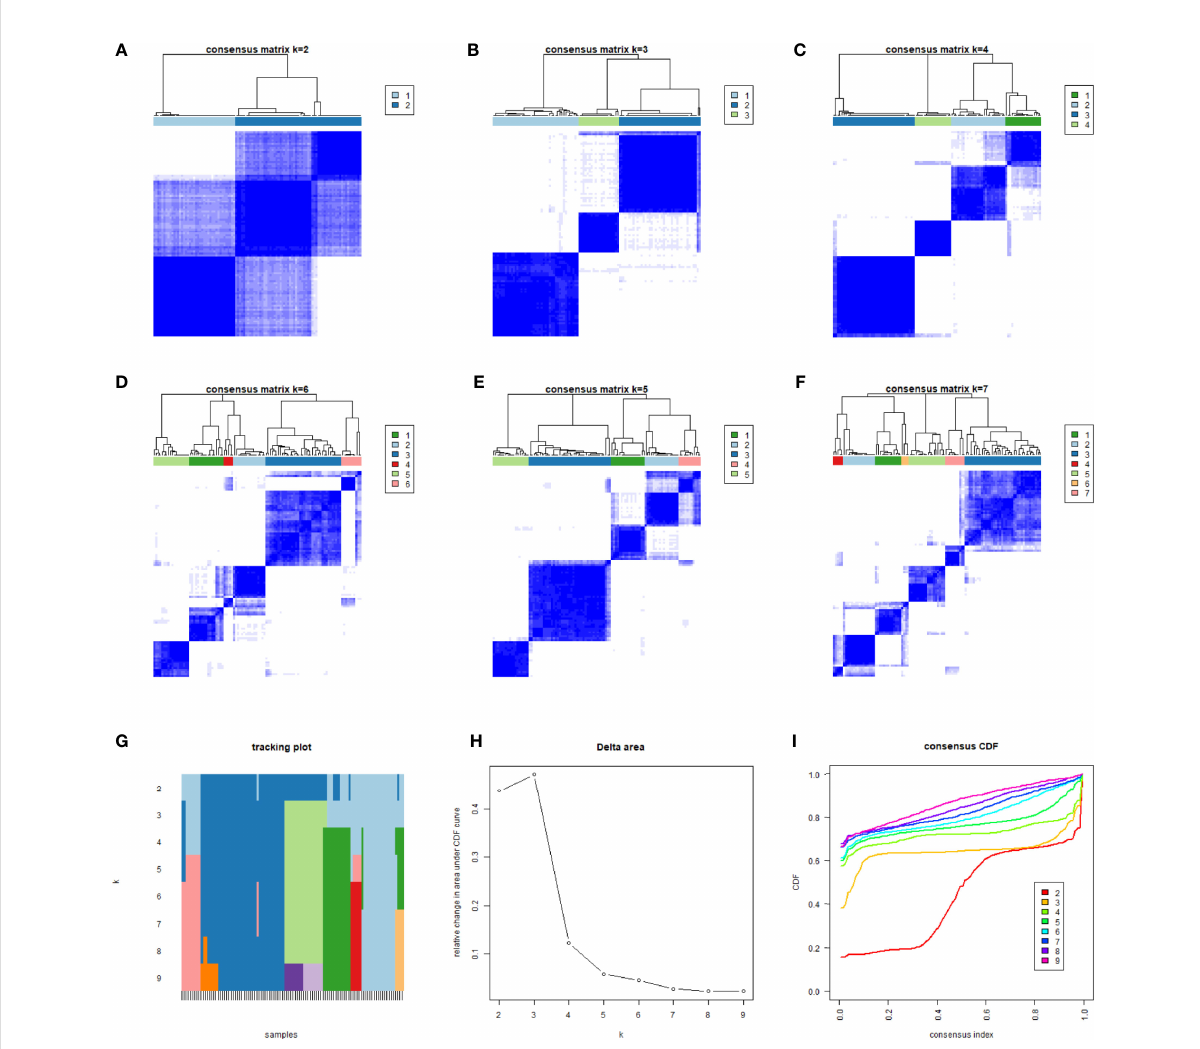
FIGURE 4 We classi fi ed 104 different samples through unsupervised clustering. According to the obtained correlation results among types (A – F) , the number of gene types was set to 3. The correlation among types was comparable; a low correlation was associated with stable classi fi cation results (G – I)